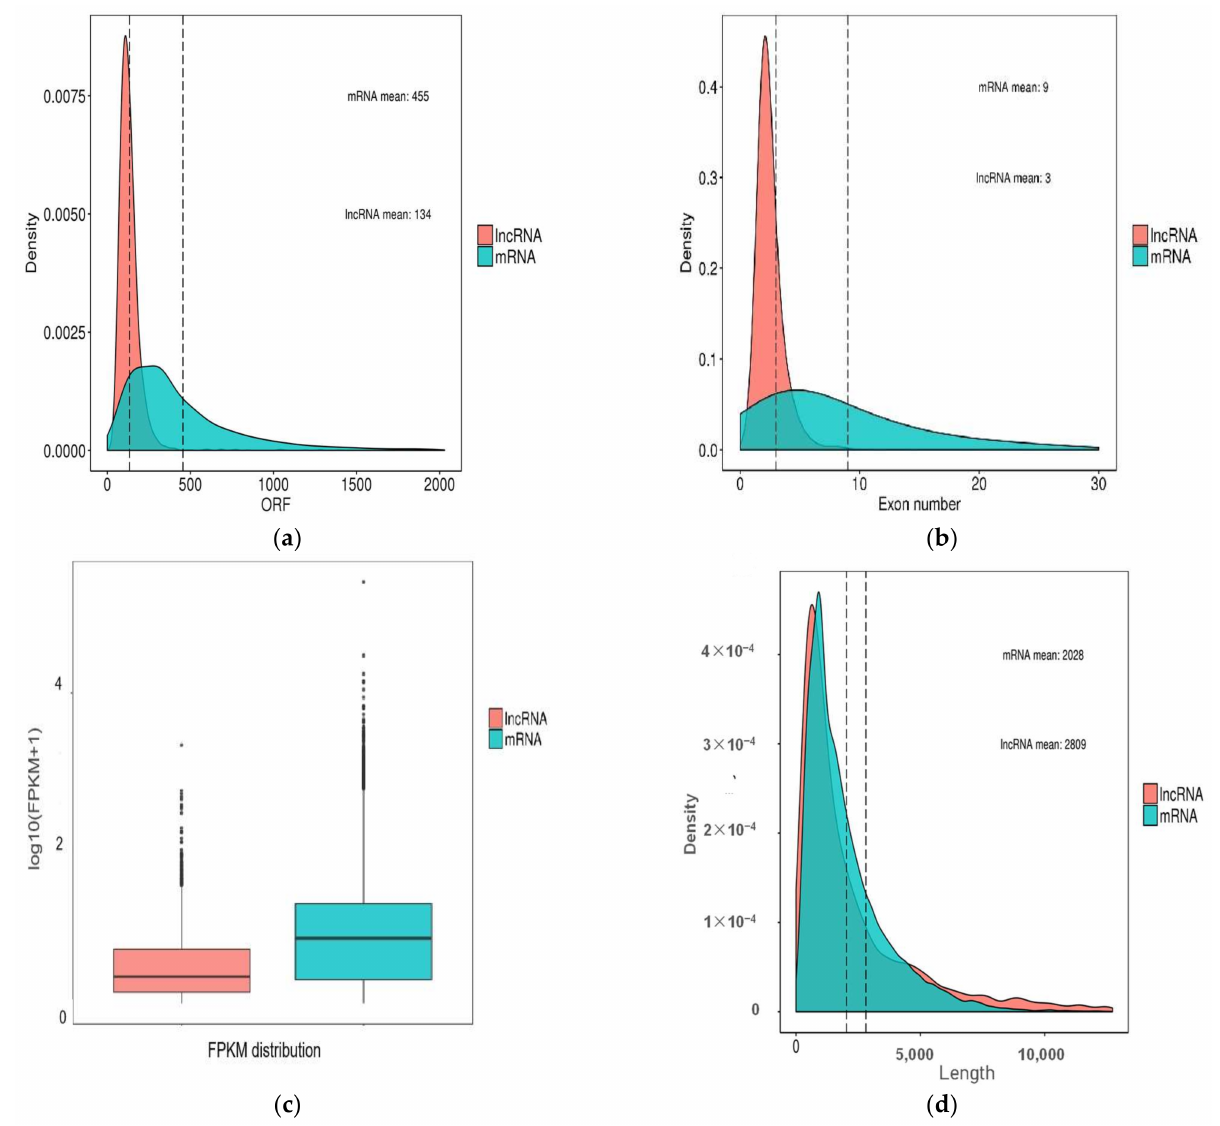
Figure 2. Genomic features of lncRNAs including annotated-lncRNAs and novel-lncRNAs compared to mRNAs. ( a ) ORF length; ( b ) exon number; ( c ) FPKM distribution; ( d )